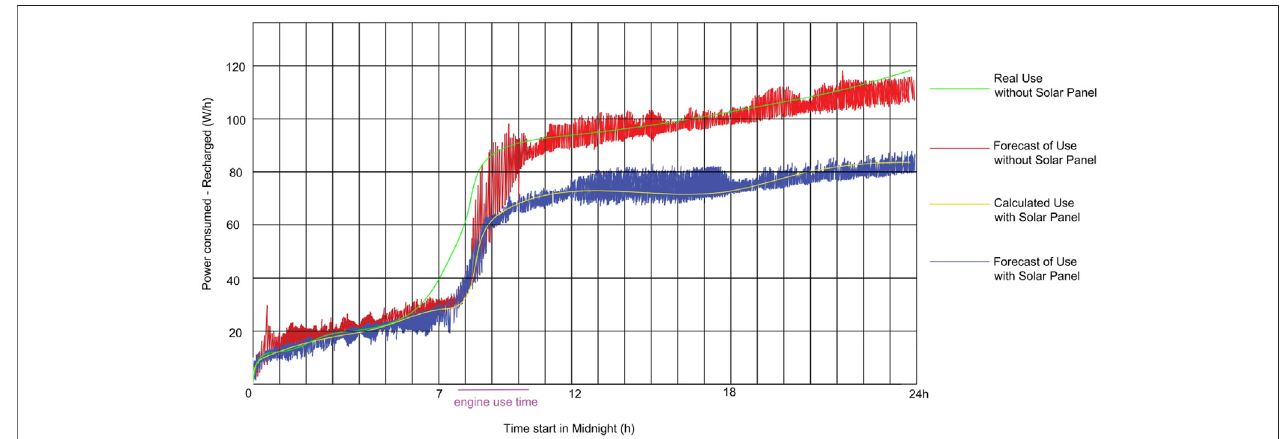
FIGURE 10 | Results for estimated consumption of the sailboat on a 24 h duration simulation, with data extracted from the N-Boat sailing experiment.